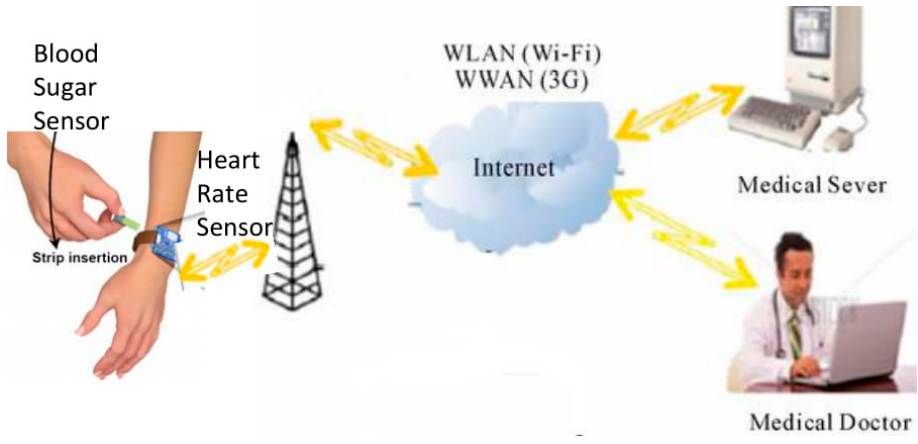
Figure 1. System Overview.